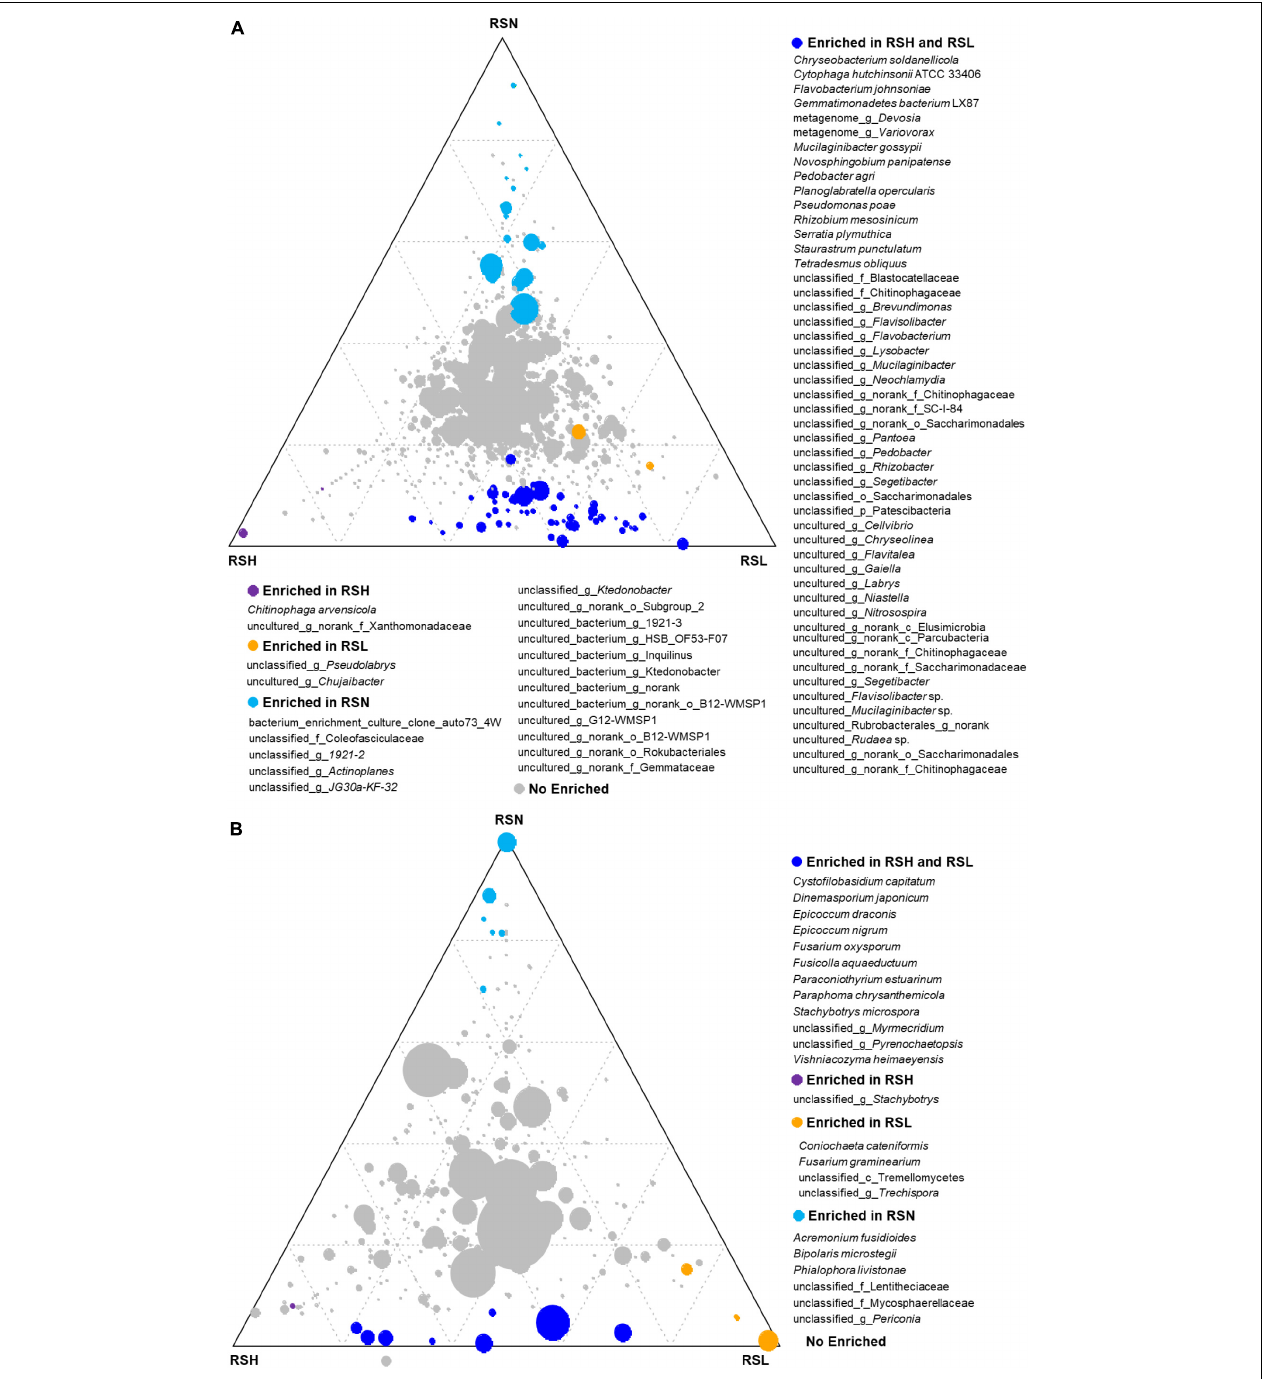
FIGURE 3 | The difference of ( P < 0.05) (A) bacterial and (B) fungal species among RSH, RSL, and RSN evaluated using the two-tailed Wilcoxon test. For each species, blue, red, yellow, and gray circles represent the differential genera enriched in RSH and RSL, RSH, RSL, and RSN, respectively.